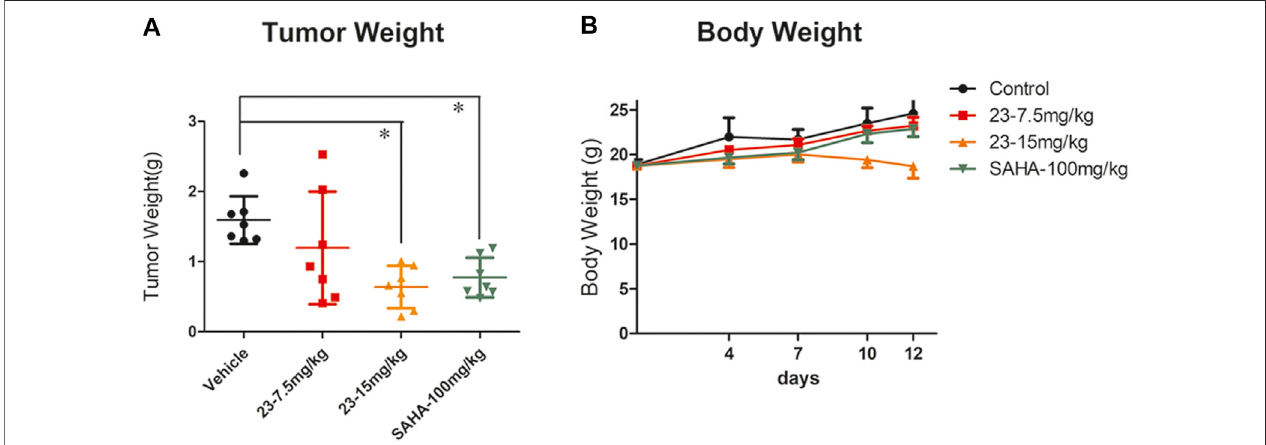
FIGURE 6 | An A20 xenograft model was included to evaluate the antitumor activity of compound 23 against B lymphoma in vivo . (A) Tumor weight after intraperitoneal administration of compound 23 at dosages of 7.5 and 15 mg/kg, or oral administration of SAHA at a dosage of 100 mg/kg. (B) Average body weight changes of compound 23 , SAHA , and vehicle groups during administration (* p < 0.05, ** p < 0.01, *** p < 0.001 vs. Control).